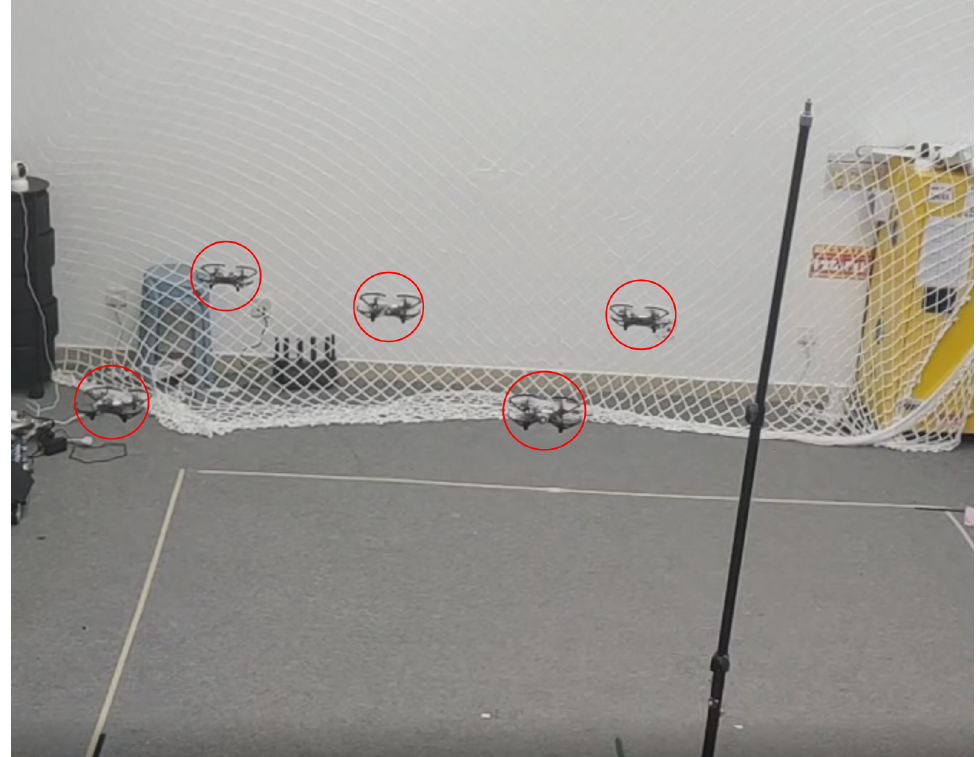
Figure 10. UAVs in the formation tracking